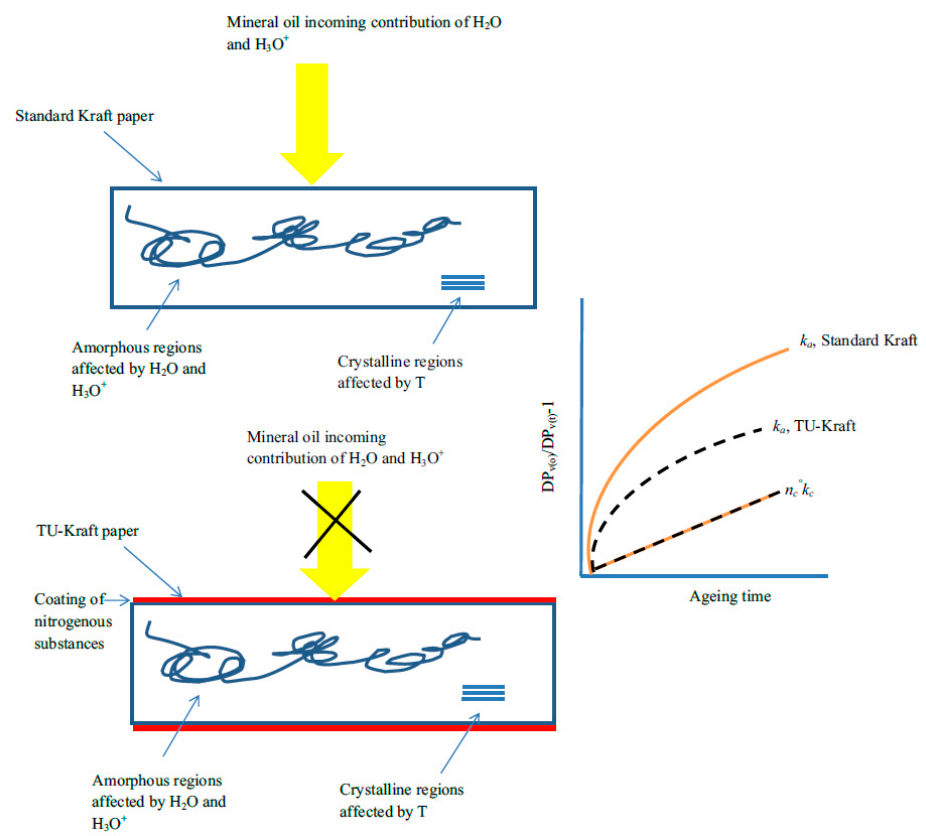
Figure 4. Hypothetical degradation aspects of a standard Kraft and a TUK paper showing the constants for the amorphous and crystalline regions of papers with the same crystallinity, from [29].